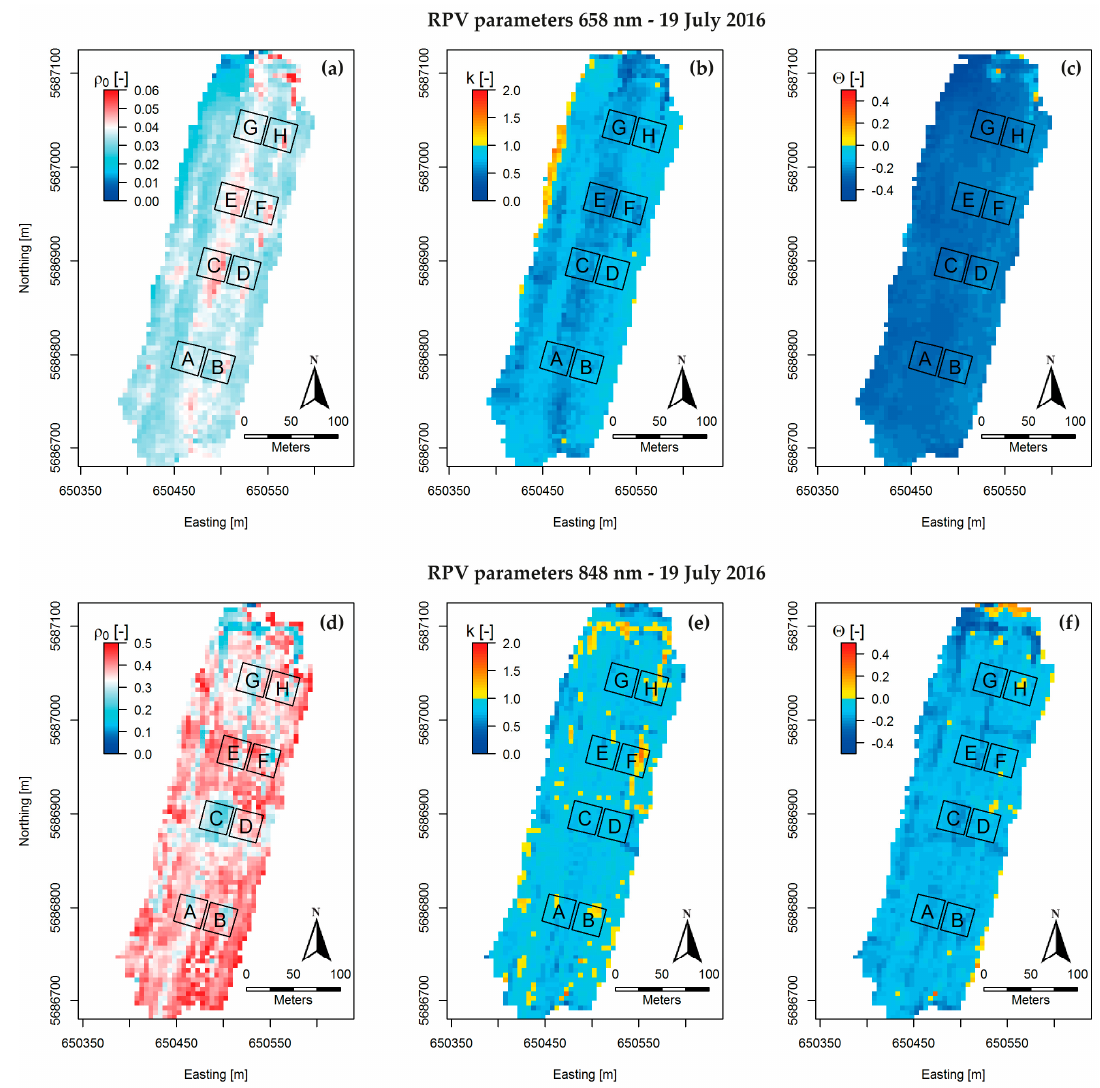
Figure 7. ρ 0 , k , and Θ parameters obtained by fitting the RPV model through the measurements of Flight 2 (19 July 2016) at 658 nm ( a – c ) and at 848 nm ( d – f ). All figures are in WGS84 UTM 31N projection.